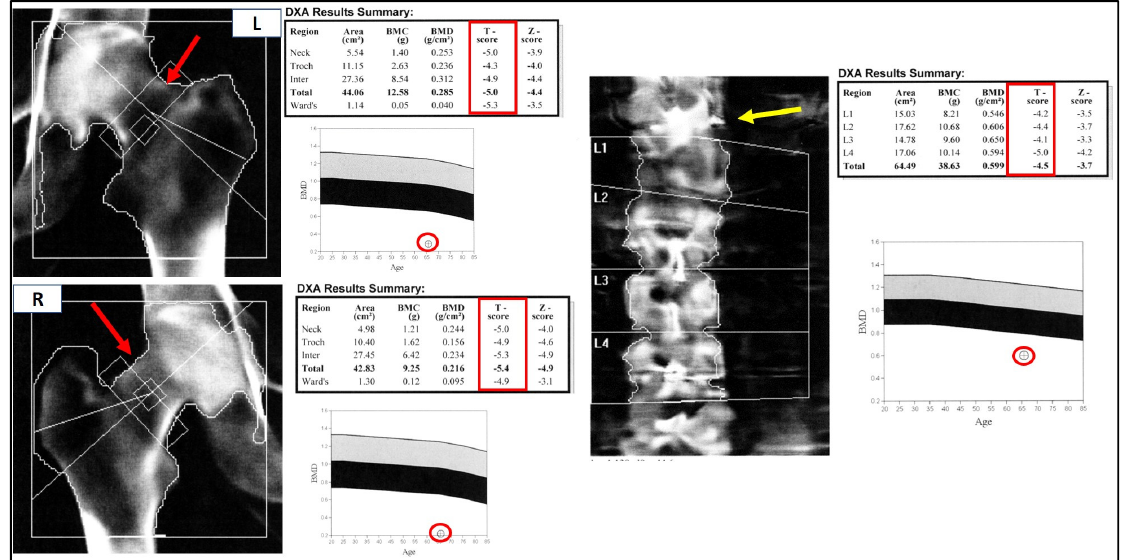
Figure 3. Bone mass evaluation by DEXA. The hips are shown at the right of the figure (left hip, L, above; right hip, R, below), the spine is on the left. The bone densitometry values (shown in the DXA results summary table) are far below the osteoporotic threshold (T-score < − 2.5 SD). The inferior panels report the patient’s bone mineral density (BMD) levels compared to those expected at the same site for age-matched subjects: normal values above the grey band (osteopenic) and frankly osteoporotic below the black band (osteoporotic). The different length of the right and left femoral necks, indicated by the red arrows, may indicate a closed fracture. The hyperdense area at T12-L1 is indicated by a yellow